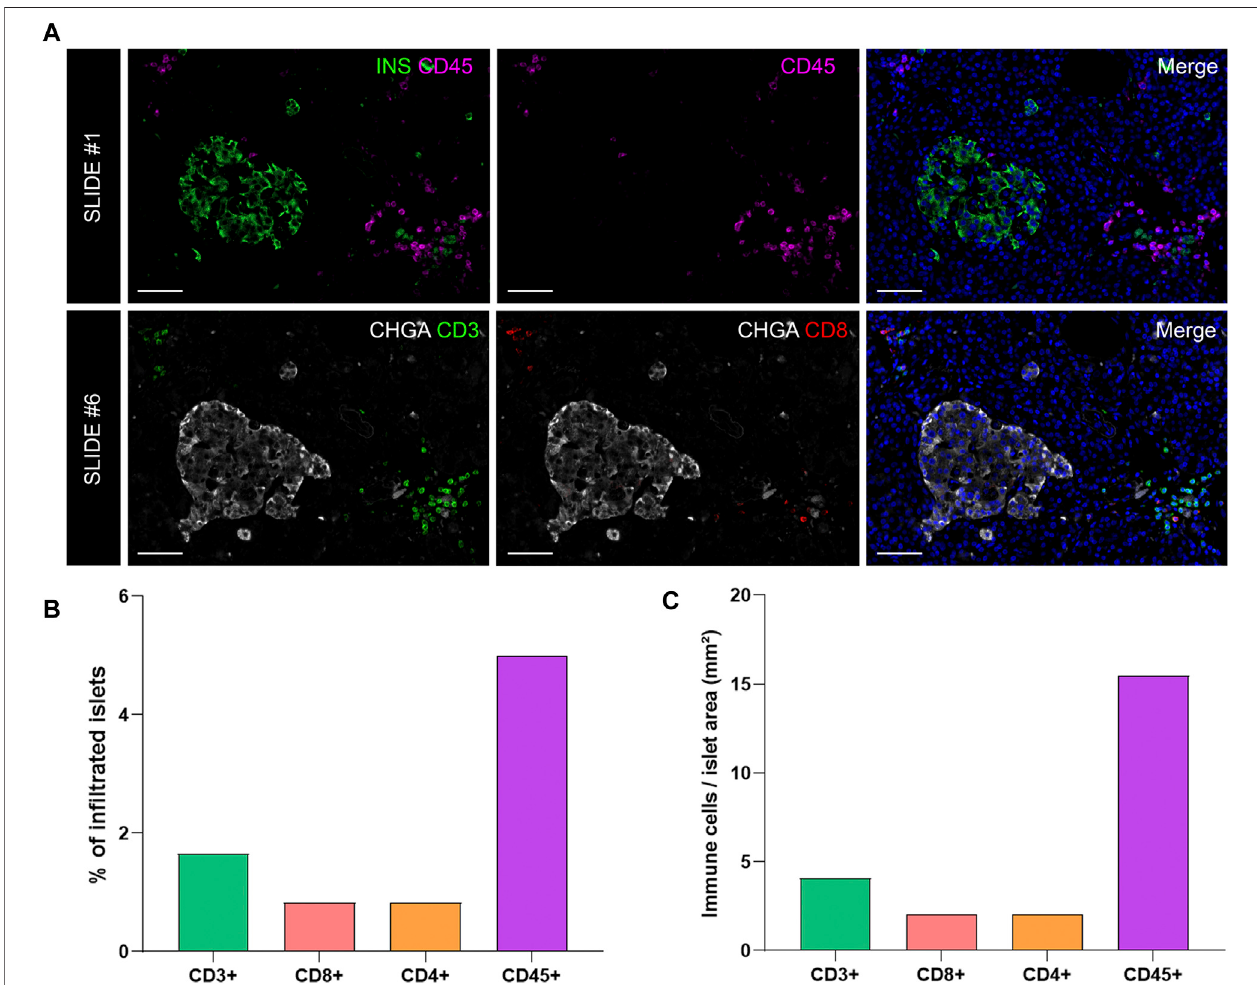
FIGURE 6 | Analysis of the proportion and density of immune in fi ltration in the exocrine and endocrine pancreas. (A) Representative images of slide #1 showing CD45 + cellsinthevicinityofaninsulin-containingislet(upperrow)andrepresentativeimagesofslide#6showingCD3+(lowerrowleft)andCD8+(lowerrowmiddle)cells close toachromogranin Apositive(CHGA+) islet. (B) Bargraphsshowthe proportion ofin fi ltratedislets byCD3+, CD8+, CD4+, and CD45+ positivecells expressed as percentage of total islets. (C) Bar graphs show the density of CD3+, CD8+, CD4+, and CD45+ cells expressed as number of cells per islet area (mm 2 ). Scale bar: 50 μ